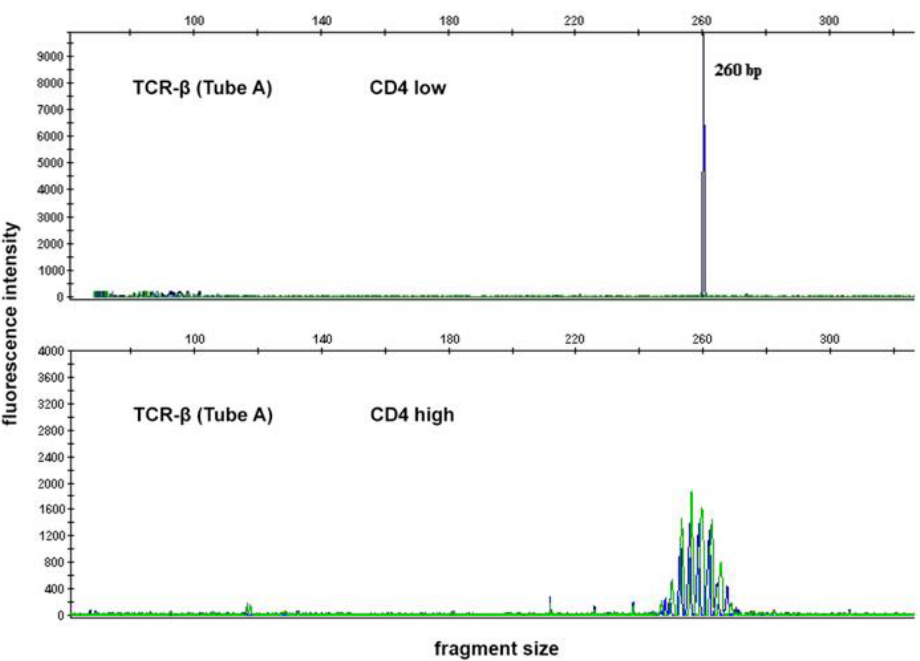
Figure 3. Case #20. Fragment analysis of T-cell receptor beta ( TCR- β ) gene PCR products from the